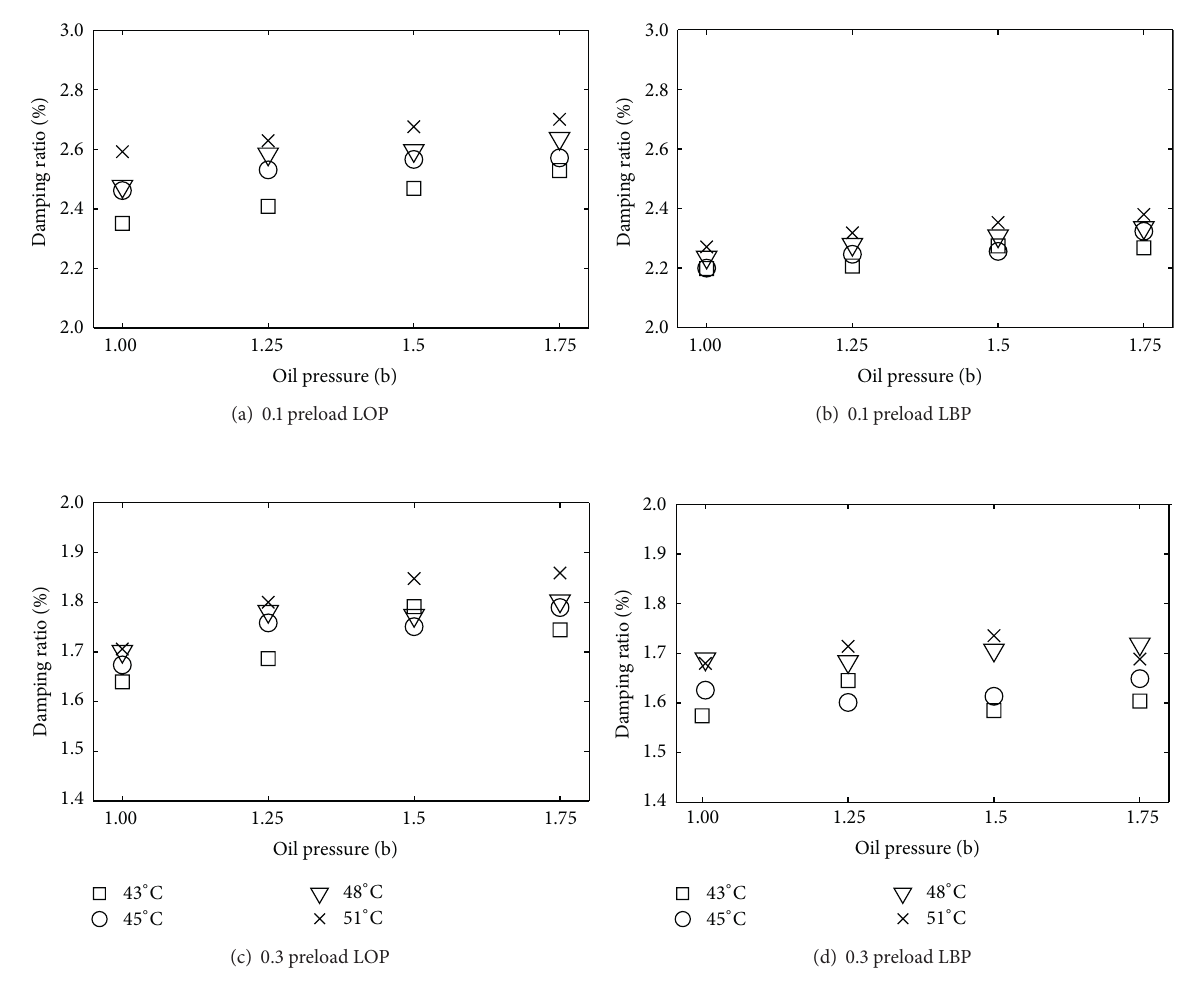
Figure 18: Effect of oil inlet temperature on the stability of